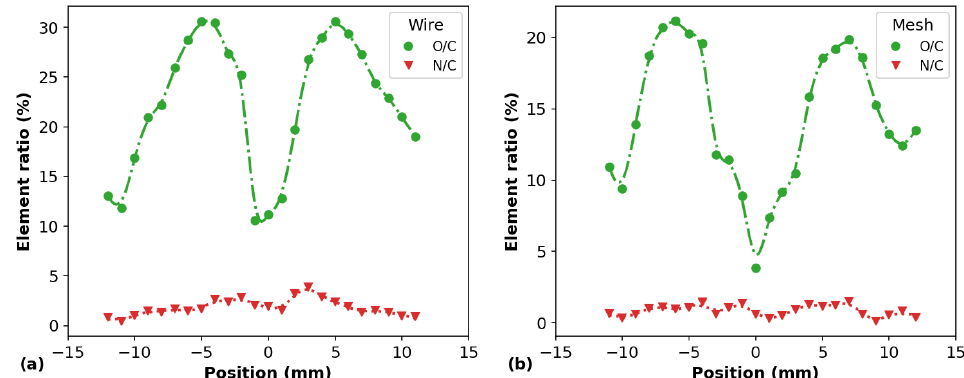
Figure 11. O/C and N/C element ratios obtained from XPS measurements on the surface of PP samples for different positions obtained for ( a ) the wire mounting and ( b ) the mesh